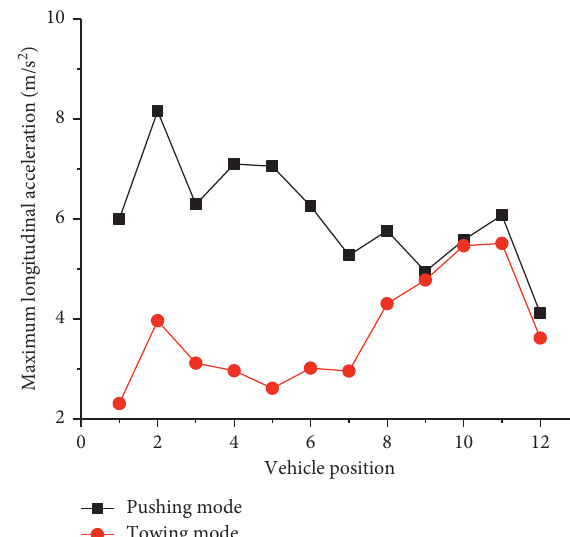
Figure 10: Maximum longitudinal acceleration when AW3 rescues